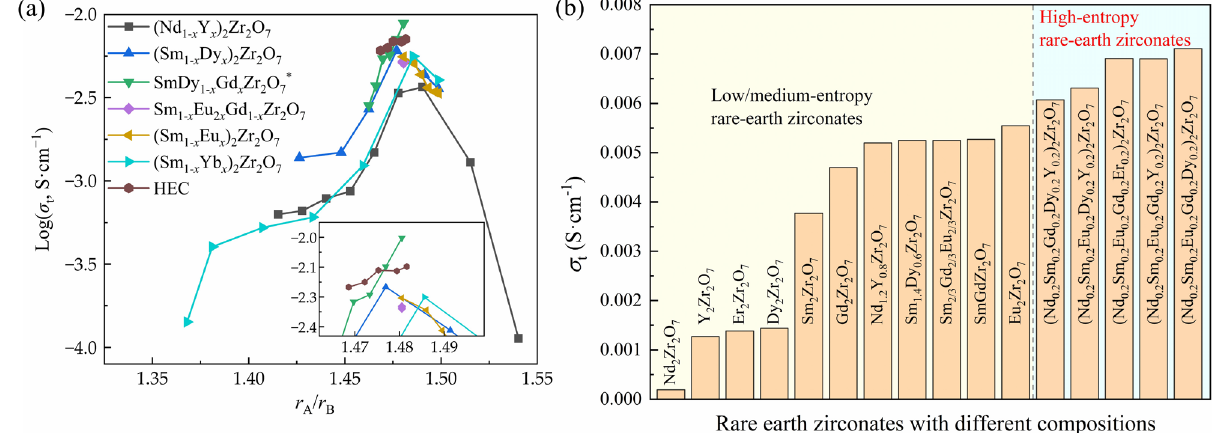
Figure 2. ( a ) The total conductivity of pyrochlores at 1073 K is a function of r A / r B . ( b ) Comparison of the total conductivity between high entropy rare-earth zirconates and other low/medium entropy rare-earth zirconates at 1073 K. Note, HEC from Ref. [75], (Sm 1 − x Yb x ) 2 Zr 2 O 7 from Ref. [89], (Sm 1 − x Eu x ) 2 Zr 2 O 7 from Ref. [122], Sm 1 − x Eu 2 x Gd 1 − x Zr 2 O 7 from Ref. [123], SmGd 1 − x Dy x Zr 2 O